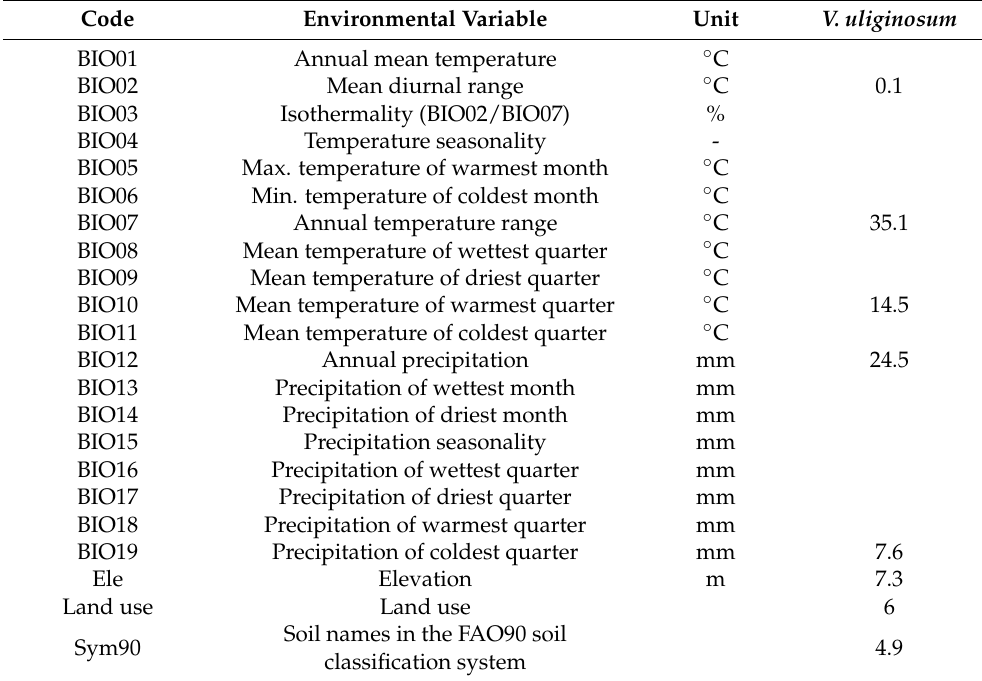
Table 1. Environmental variables and contribution rates (%) to V. uliginosum